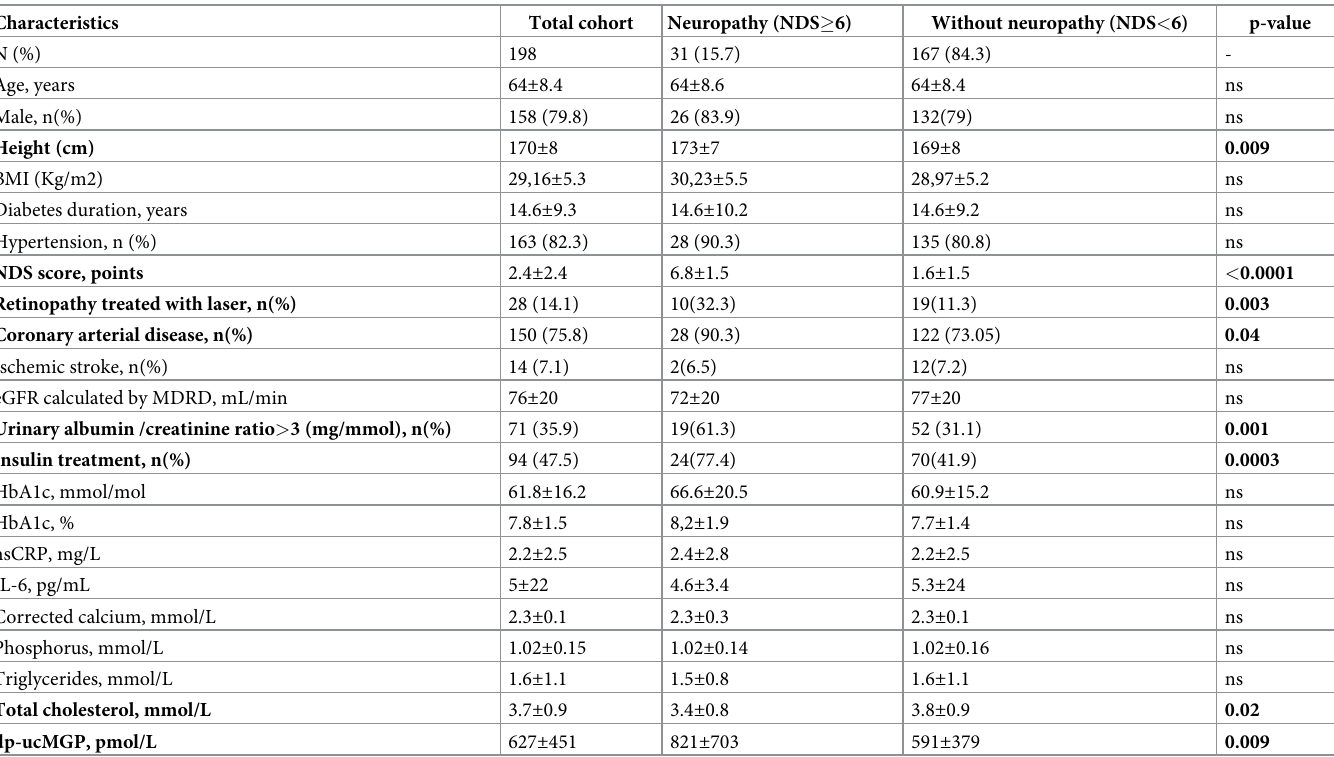
Table 1. Baseline characteristics of the patients.